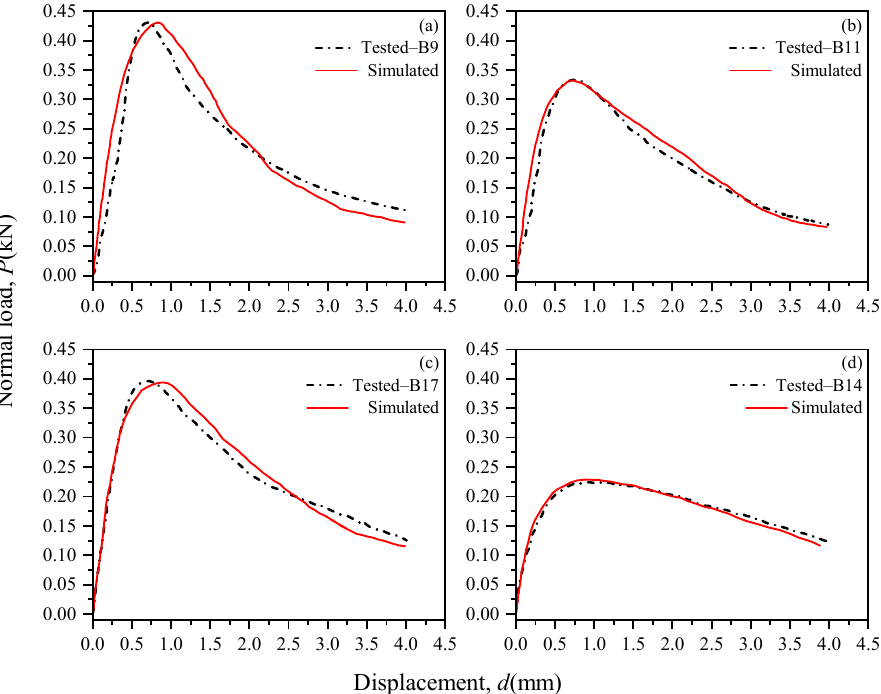
Figure 7. Simulation and test result [10] comparison of the three-point bending test of frozen soil specimens with a 0.1 mm/min loading rate: ( a ) Specimen’s temperature = − 2.89 °C; ( b ) Specimen’s temperature = − 1.72 °C; ( c ) Specimen’s temperature = − 1.56 °C; ( d ) Specimen’s temperature = − 0.53 °C.